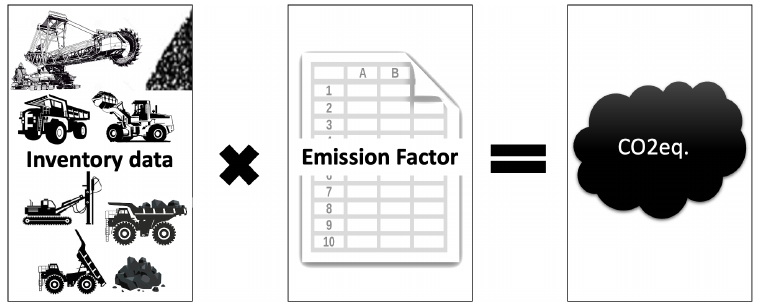
Figure 3. The use of emission factors in mining operations to assess GHG